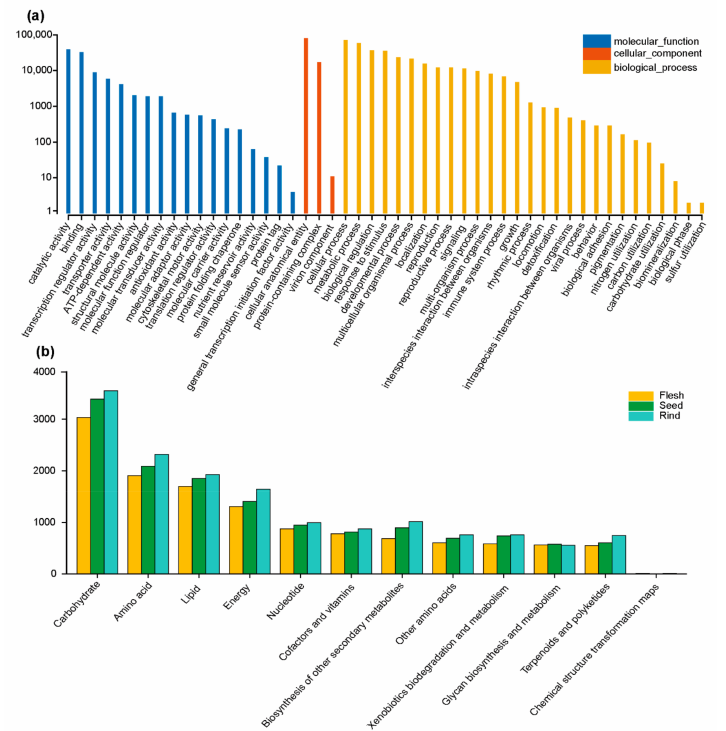
Figure 3. GO and KEGG metabolic pathway annotation of unigenes containing SSRs. ( a ) Distribution of GO classification of unigenes carrying SSRs; ( b ) Distribution of KEGG classification of unigenes carrying